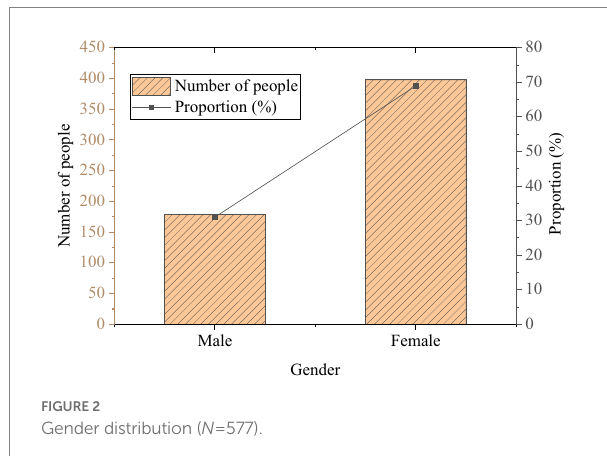
FIGURE 1 Chain mediating hypothesis model.